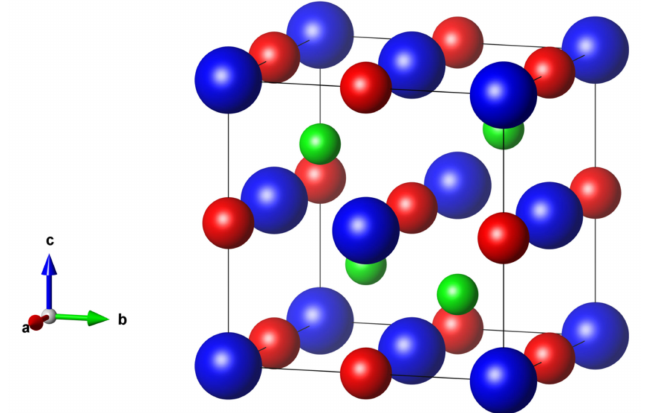
Figure 1. Crystal structure of RNiSb compounds. R atoms are shown in blue, Ni—in green, Sb—in